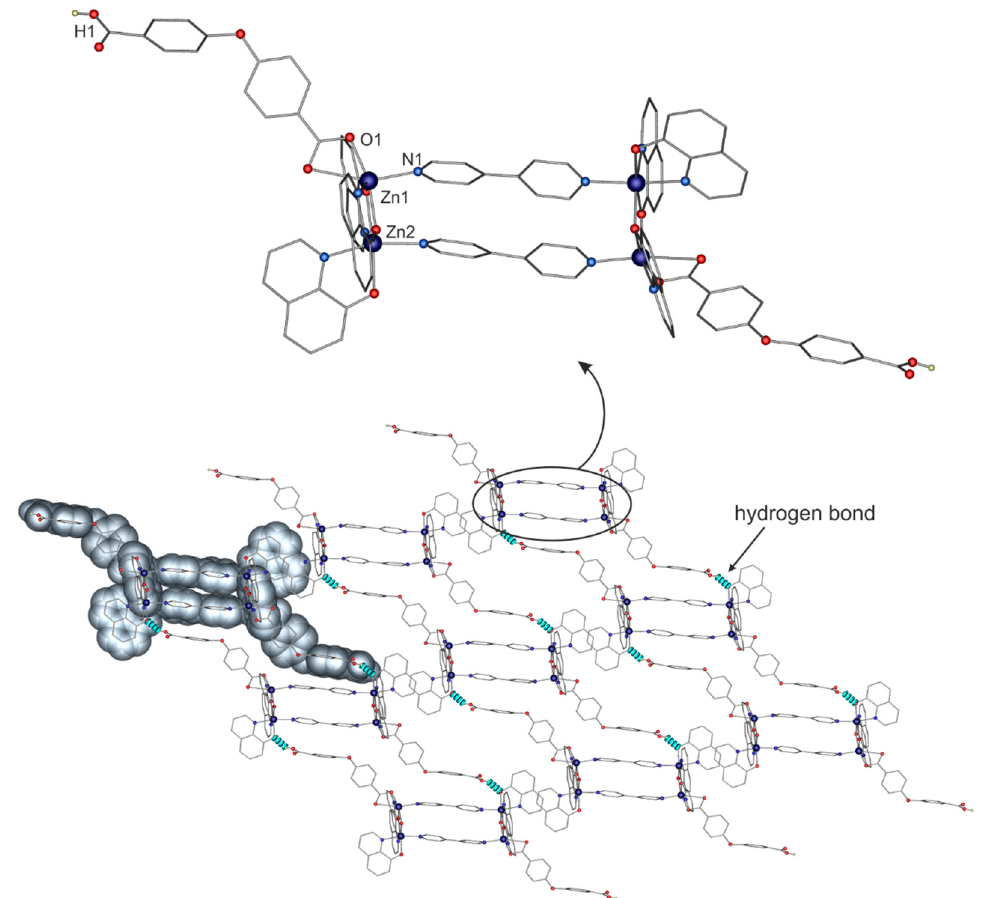
Figure 2. Molecular and supramolecular structure of HP4 ; zinc = violet, oxygen = red, nitrogen = blue, carbon = grey. Hydrogen bonds are marked with blue dashed lines. Hydrogen atoms have been omitted for clarity.